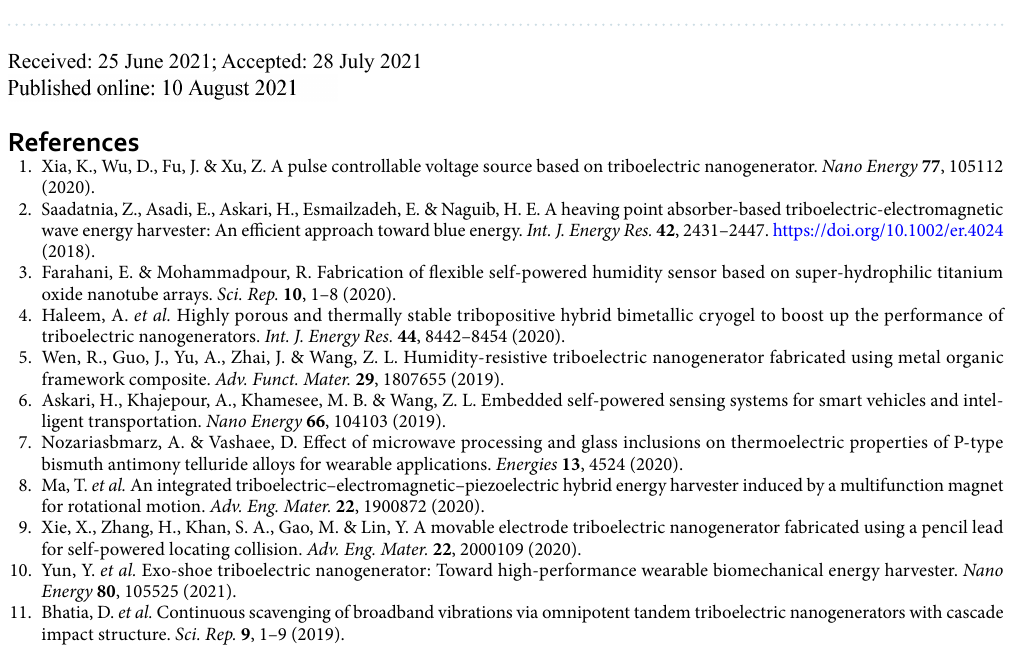
Figure 8. Simulated pulse current for ( a ) Ti foil, ( b ) TiO 2 thin film, ( c ) TiO 2 nanoparticulate film, and ( d ) TiO 2 naotube film at different